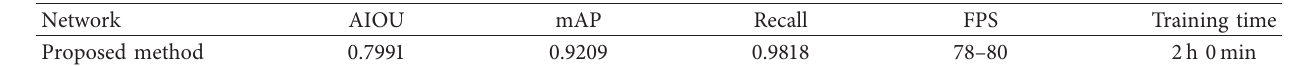
Table 5: The loading test results of the pretraining weights for the improved